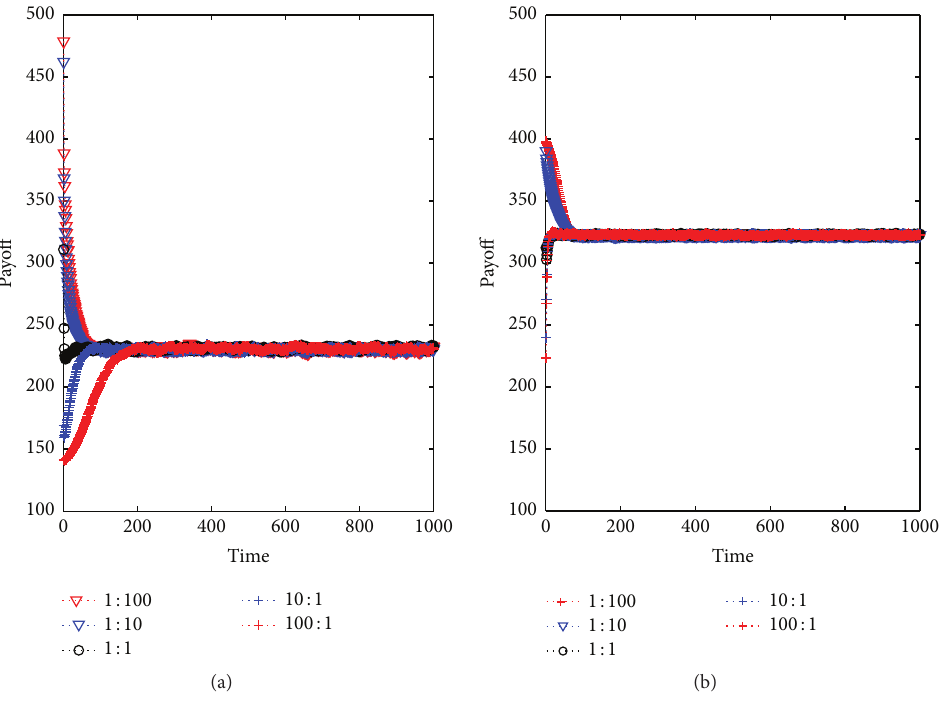
Figure 2: The evolution for payoff of (a) greedy and (b)